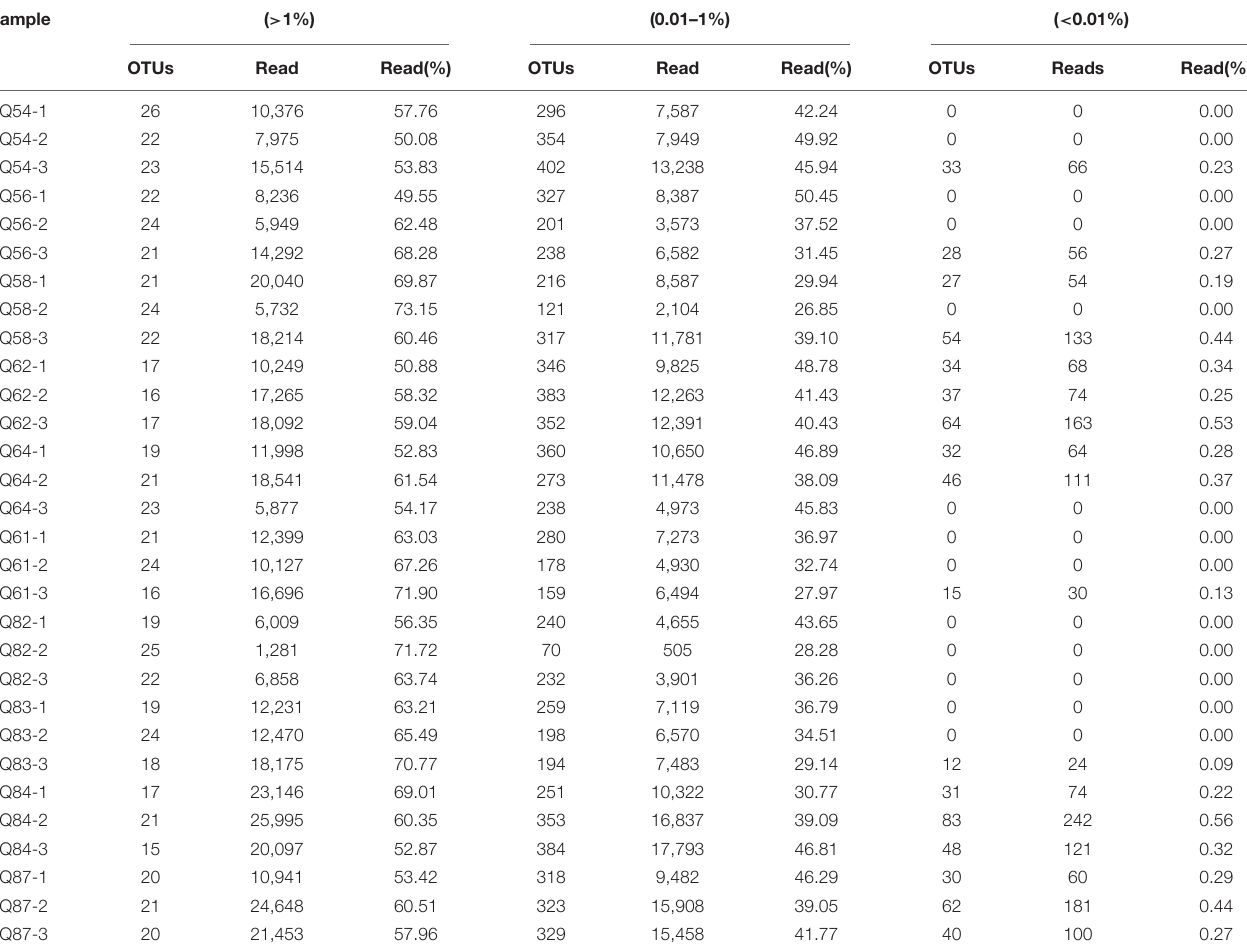
TABLE 3 | Sequencing information of the abundant, intermediate, and rare OTUs of sediment samples collected from the South China Sea.